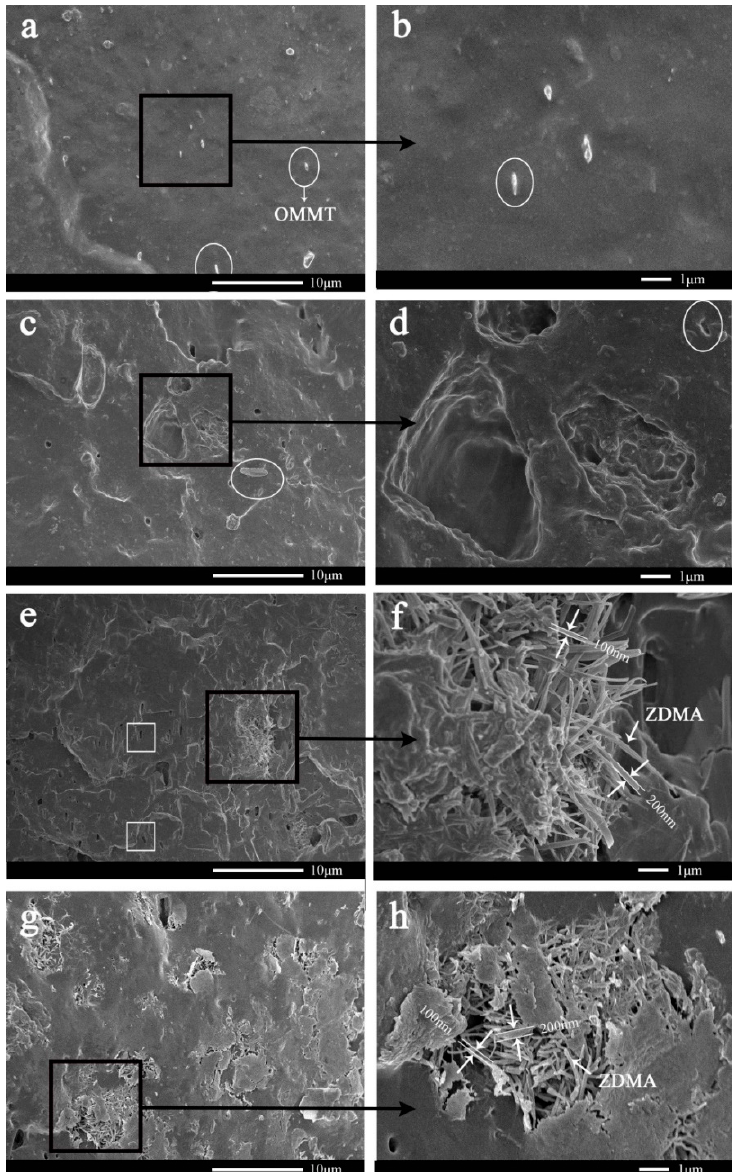
Figure 7. SEM images of ( a , b ) in-situ-NC, ( c , d ) in-situ-NC/ZDMA25, ( e , f ) in-situ-NC/ZDMA40, and ( g , h ) ph-NC/ZDMA40.